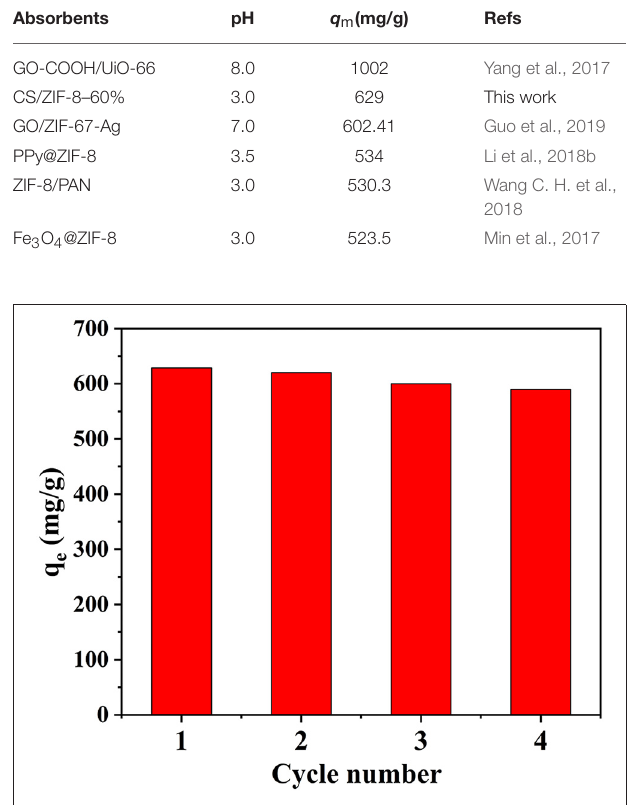
FIGURE 7 | Elution cycle experiment of CS/ZIF-8–60% for U(VI) adsorption.